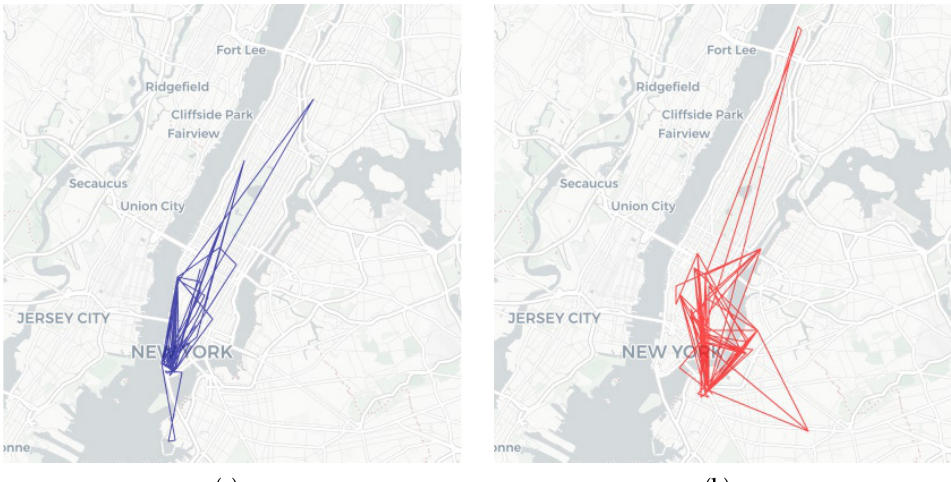
( b ) Figure 2. An example of a real trajectory ( a ) and a synthetic trajectory generated by STS-EPR ( b ) in New York City. Although the two trajectories at a first inspection are quite different, the synthetic trajectory ( b ) preserves some important characteristics of real trajectories. Both trajectories are concentrated in the most relevant locations (close to Manhattan), they have mostly small jump lengths and a small number of trips to distant places (power law behaviour of jump lengths [28]). Plots generated with scikit-mobility